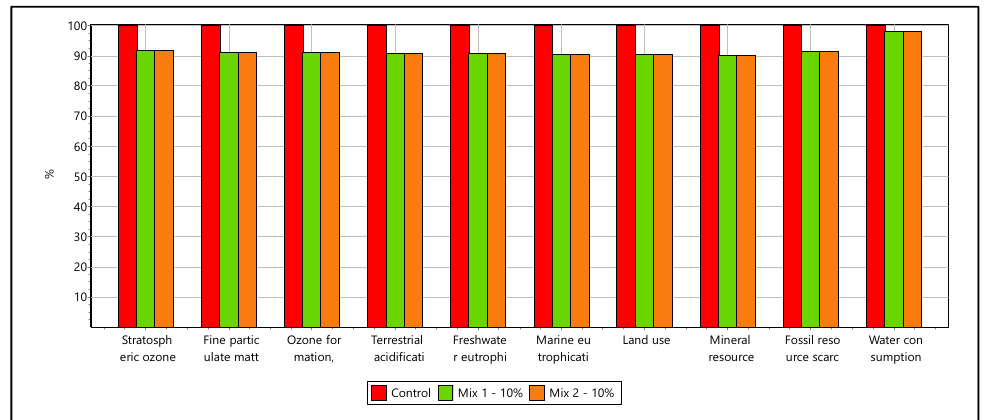
Figure 11. LCA comparison of secondary material cement replacement across different impact categories.